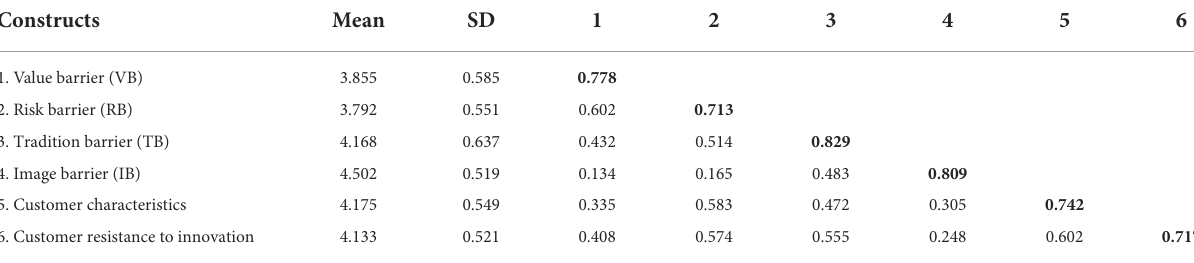
TABLE 3 Descriptive statistics, correlation matrix, and discriminant validity via Fornell and Larcher.